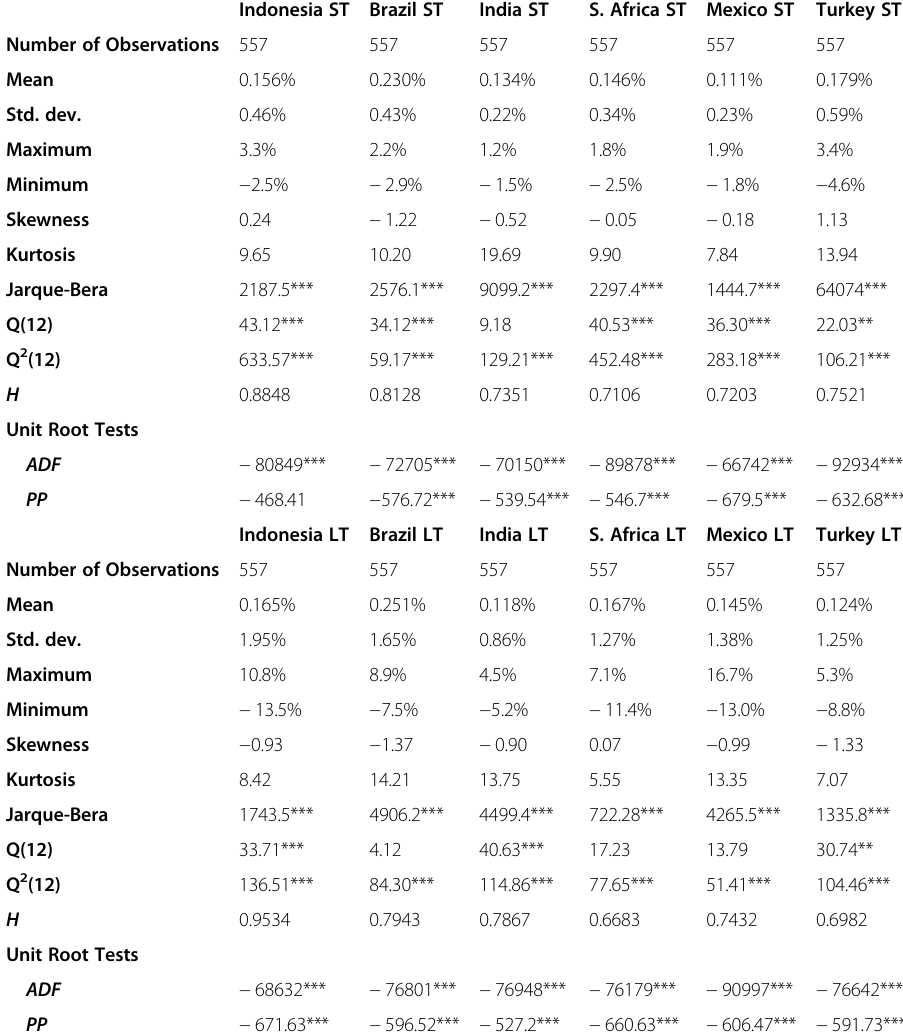
Table 2 Preliminary analysis of the